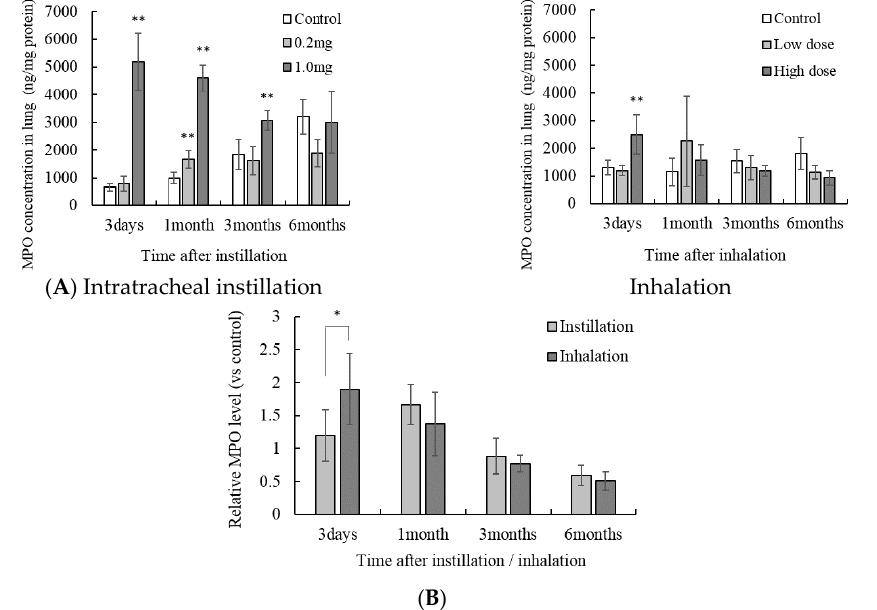
Figure 6. Influence of NiO nanoparticle exposure on the concentration of myeloperoxidase (MPO) in the lung tissue. ( A ) The concentration of MPO in the lung after intratracheal instillation and inhalation. The MPO concentration was measured using ELISA. Values are mean ± SE ( n = 5). Significant differences versus control group are indicated in the figure (ANOVA, Dunnet). ** p < 0.01; ( B ) Comparison of 0.2 mg intratracheal instillation and high dose inhalation. The data show the relative level of MPO protein concentration against each control group. * p < 0.05 (ANOVA, Tukey).